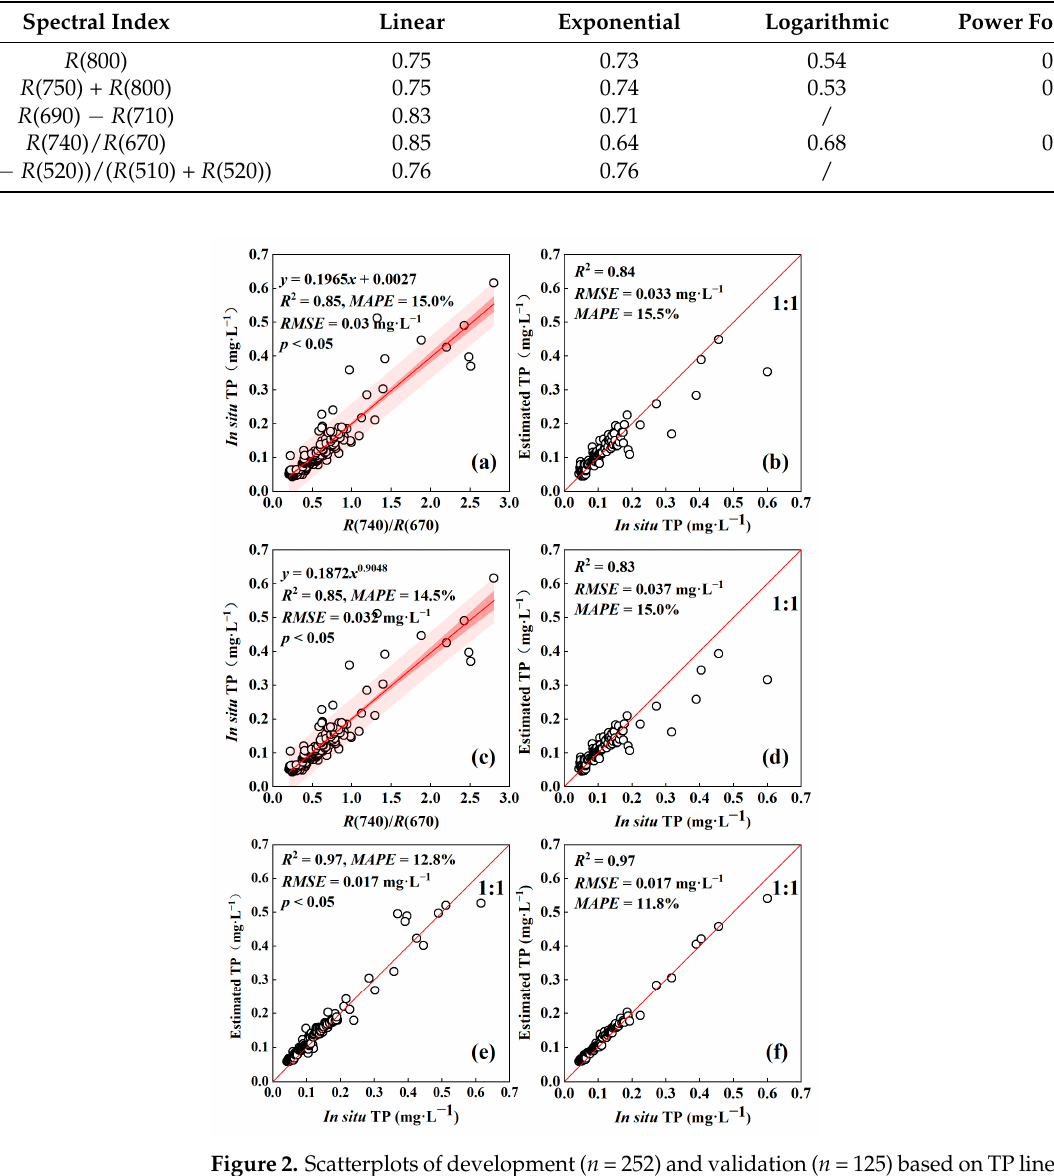
Table 3. The R 2 of four fitting models for TP with optimal spectral indexes.